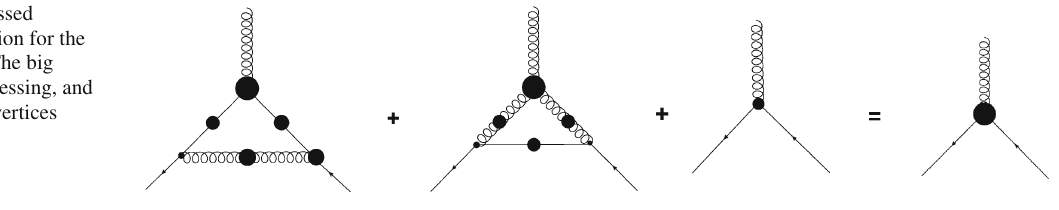
imation. The BSE is represented diagrammatically on Fig. 5 where blobs stand for fully dressed quark and gluon prop- agators, with the dressed vertices represented by big